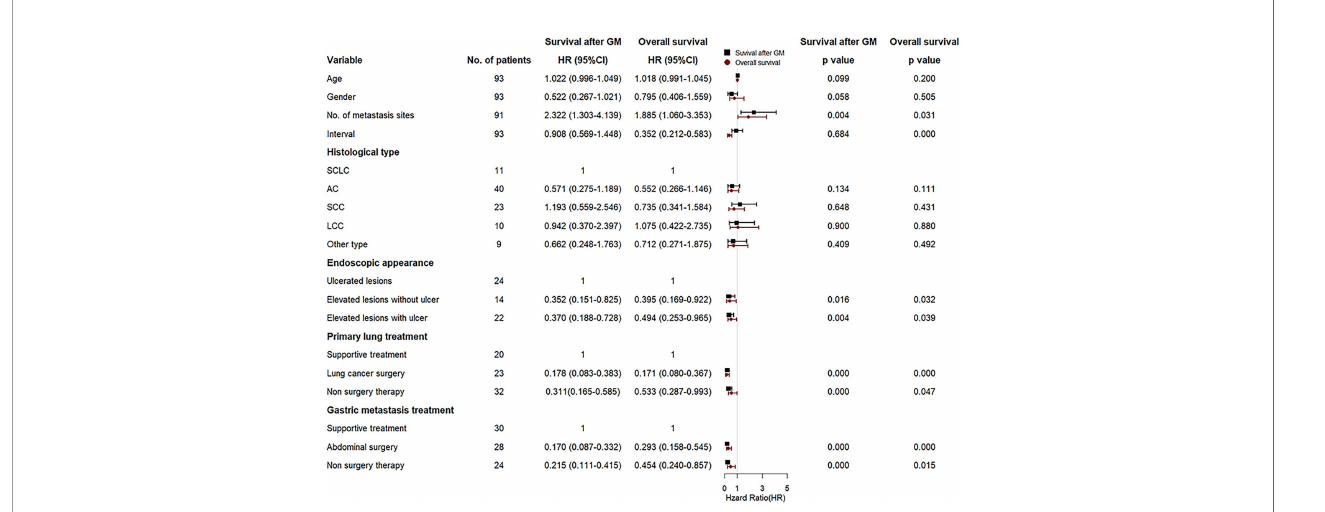
FIGURE 6 | Forest plot for the univariate Cox regression analyses of variables that may affect survival after gastric metastasis and overall survival of the gastric metastasis from lung cancer (GMLC)